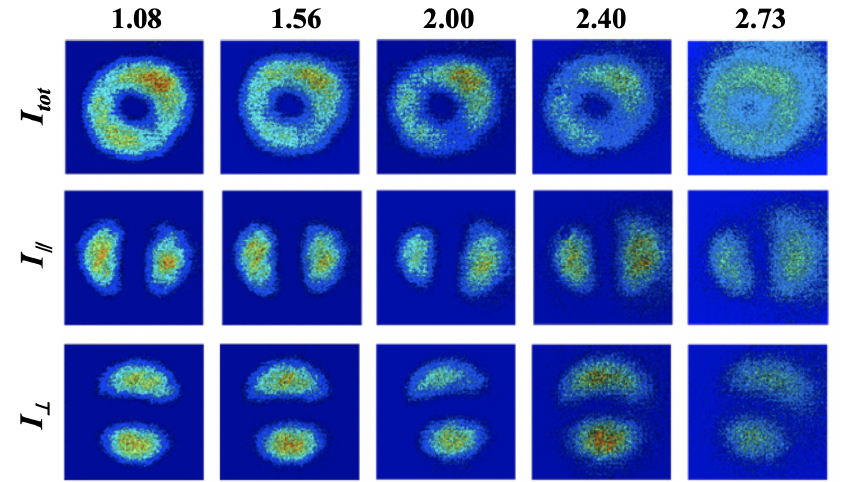
Figure 6. The results of experimental measurements of I tot , co- I (cid:107) and cross- I ⊥ polarized components of a CVB beam with l = + 1, σ = − 1 transmitted through a cuvette containing different concentrations of polystyrene microspheres solutions of various OD : 1.08, 1.56, 2.00, 2.40, 2.73.